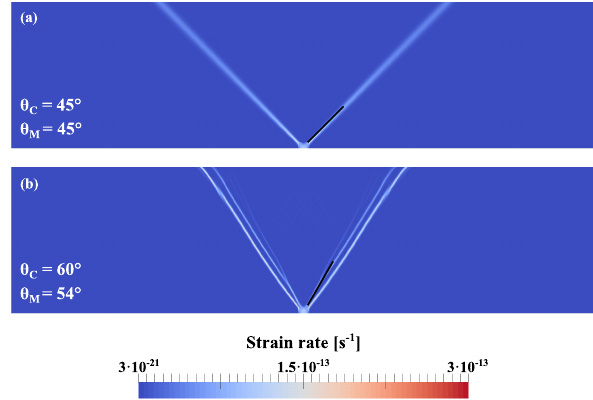
Figure 7. Strain rate norm fields for (a) φ = 0 ◦ and (b) φ = 30 ◦ for a 512 × 128 elemental resolution. The models were run in extension for 1000 NIs. Black lines indicate the theoretical Coulomb angle θ C . Measured shear band angles θ M are also